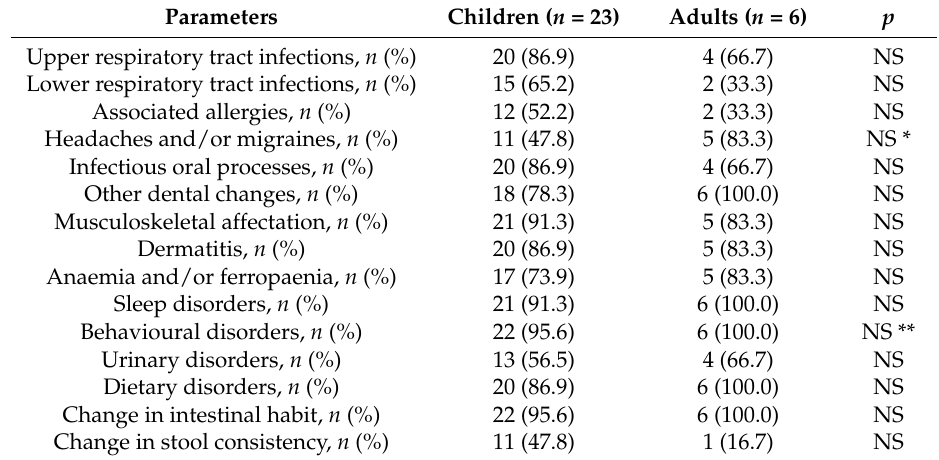
Table 2. Baseline characteristics of the symptoms and signs of NCGS in children and adults.